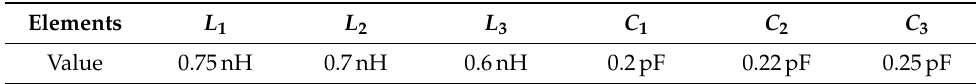
Table 1. Values of the OMN